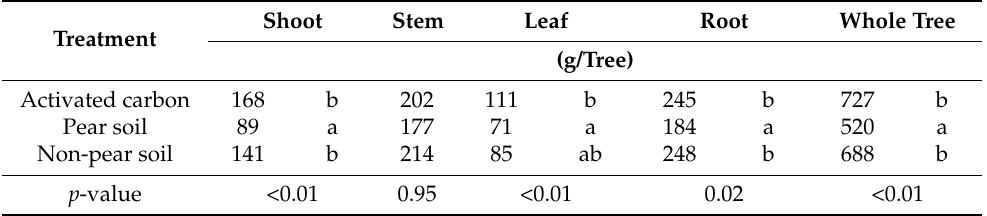
Table 5. The dry weight of trees in soil mixed with activated